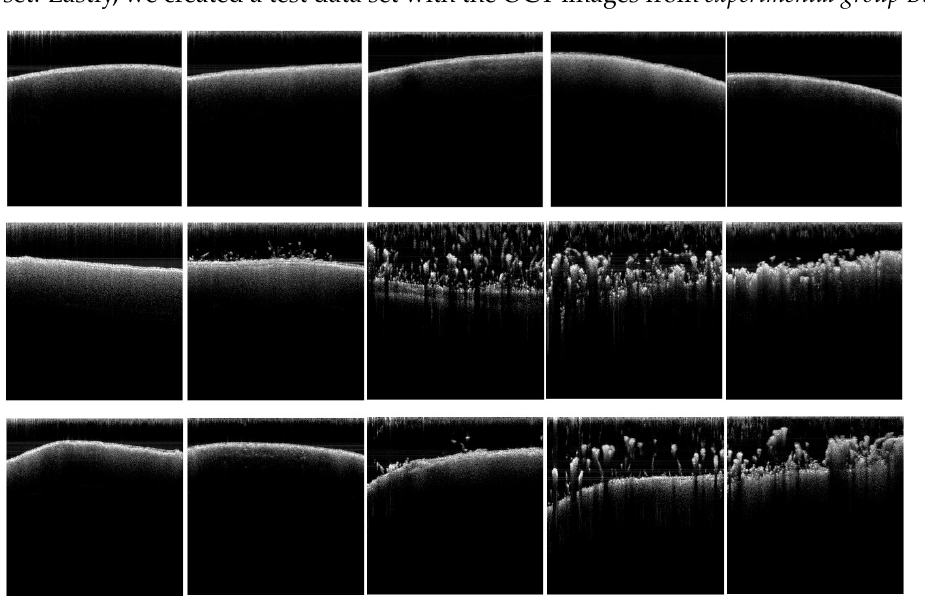
Figure 1. Exemplar OCT images of peanut kernels in the three samples. The first row is for a kernel in our control group. The second one represents another kernel from experiment group A and the last row for experiment group B. The OCT images in each row show mold growing on the peanut kernels after a certain period, from 0, 24, 48, 72, and 96 h respectively (left to